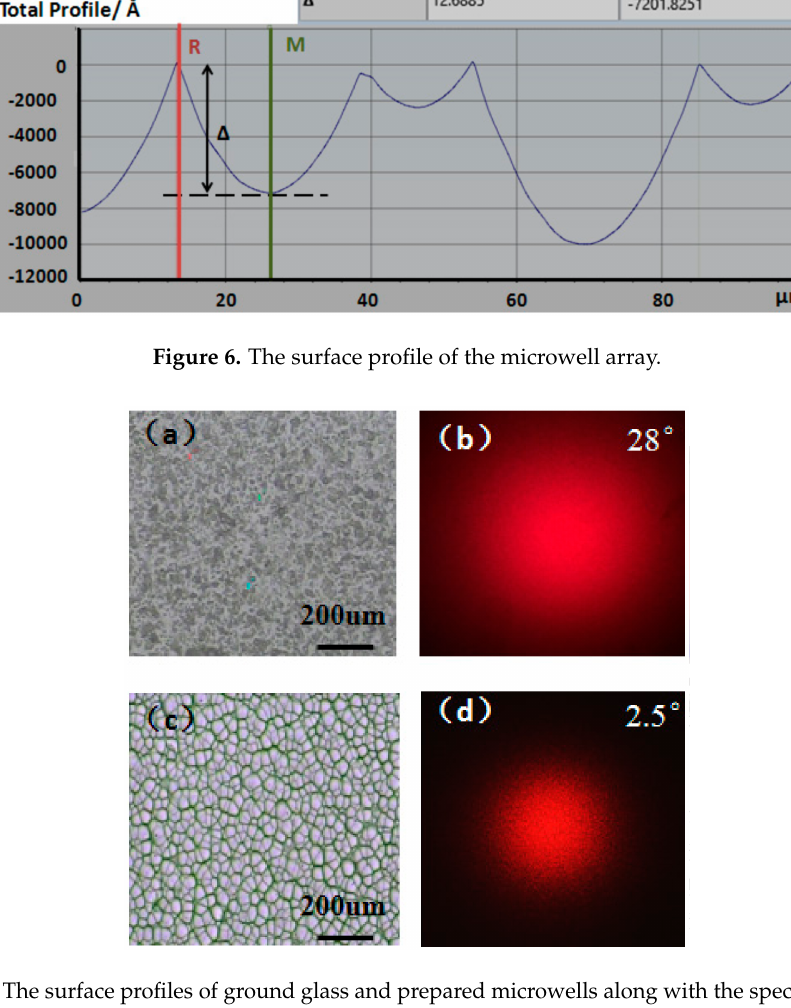
Figure 7. The surface profiles of ground glass and prepared microwells along with the speckle patterns for comparison: ( a ) the surface profile of ground glass; ( b ) the speckle pattern produced by ground glass; ( c ) the surface profile of prepared microwells; ( d ) the speckle pattern produced by prepared